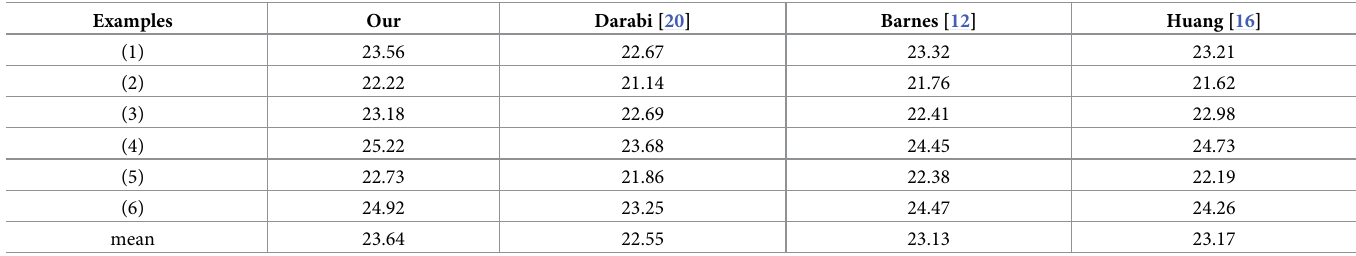
The objective of image completion is to complete an image in the most satisfactory manner. Some primary methods [24], [25], [26] exist to measure the quality of the result. The first is visual inspection; the second is peak signal to noise ratio (PSNR). As shown in Fig 8, we Table 1. Image completion performance measured in